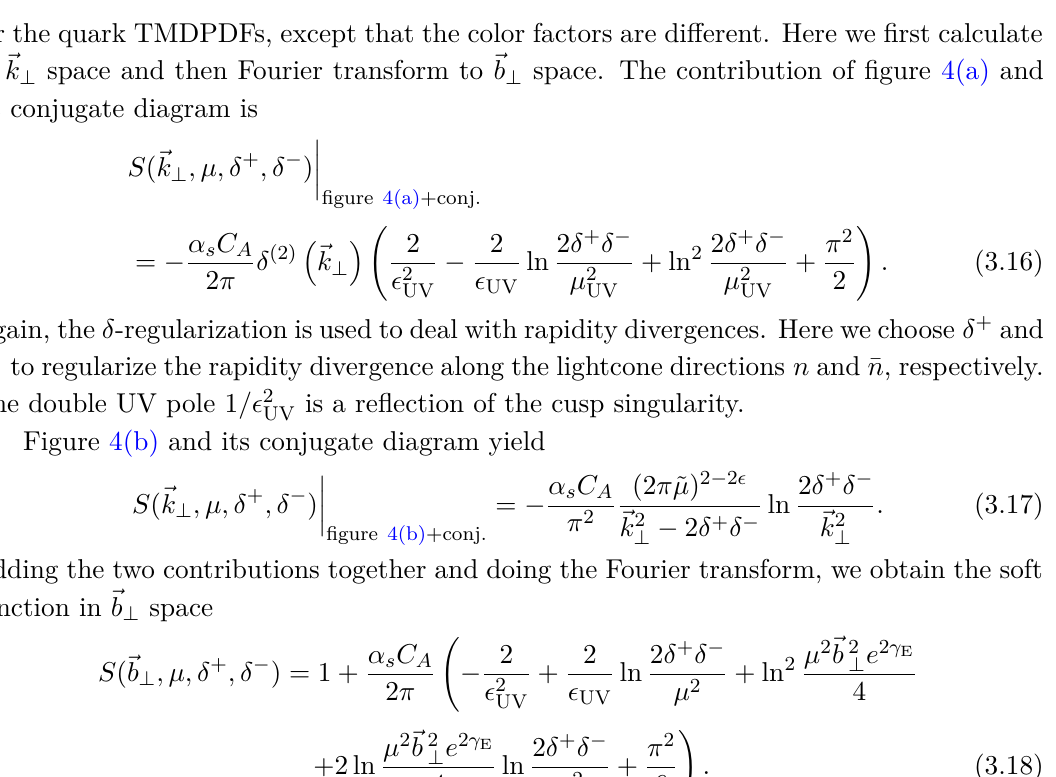
Figure 4 . One-loop Feynman diagrams for the soft function, where the double-lines denote gauge